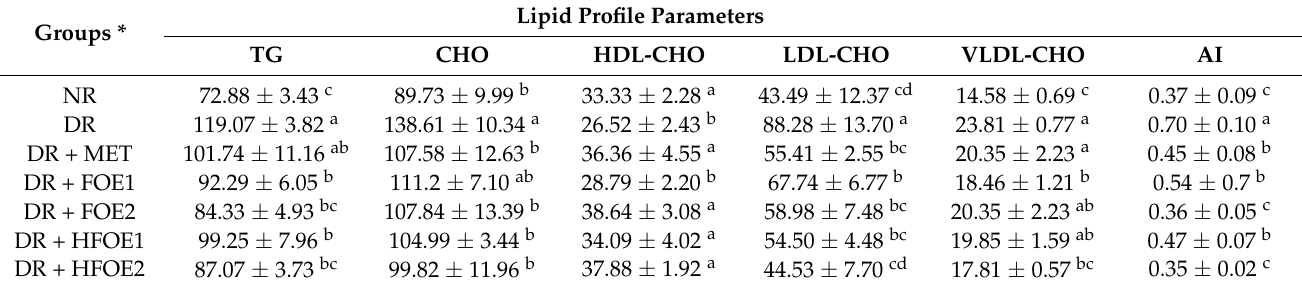
Table 5. Effect of orally administrated FOE and HFOE on lipid profile (mg dL − 1 ) and atherogenic index in STZ-induced diabetes in rats (mean ± SE), n = 8.